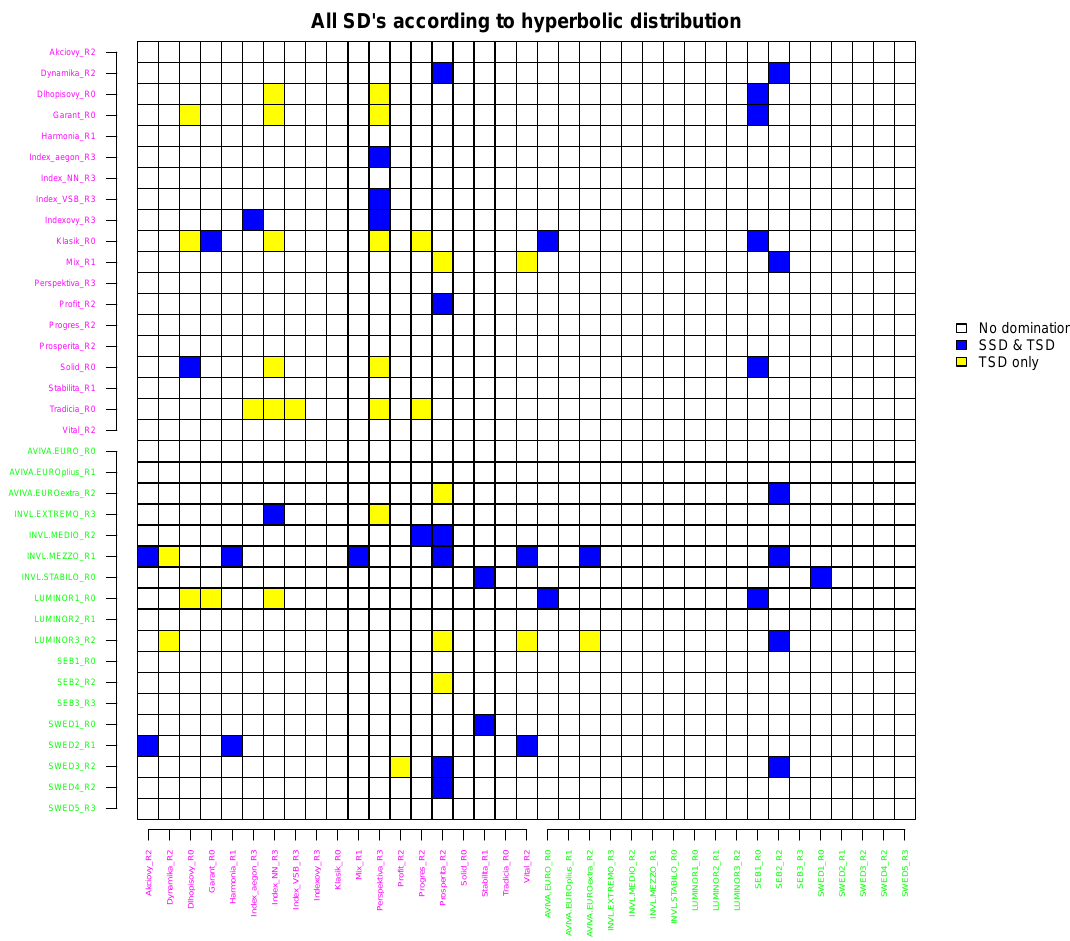
Figure 9. SD relations for all PFs assuming hyperbolic